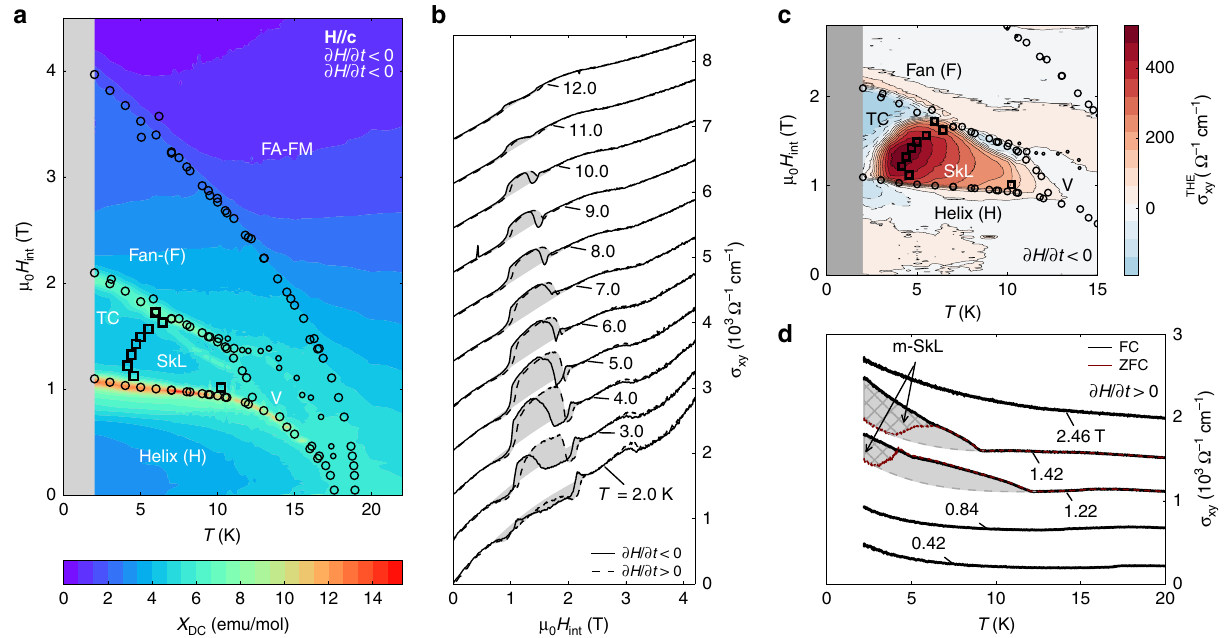
Fig. 2 Field-induced phase transitions in Gd 3 Ru 4 Al 12 and topological Hall effect in the SkL phase. a Contour plot of magnetic susceptibility χ DC = ∂ M / ∂ H in which we distinguish helical (H), fan-like (F), transverse conical (TC), and skyrmion lattice (SkL) states, as well as the as-yet unidenti fi ed phase (V). FA- FM labels the fi eld-aligned ferromagnetic state. Black open circles are phase boundaries obtained from χ DC for ∂ H / ∂ t , ∂ T / ∂ t < 0 (small symbols bound phase V. c.f. Supplementary Note 7). The transition between SkL and TC is marked by black open squares, corresponding to the onset of hysteresis between FC and zero- fi eld cooled (ZFC) cases in panel ( d ). b Isotherms of the Hall conductivity σ xy at various temperatures. Dashed and solid lines mark increasing and decreasing magnetic fi elds, respectively. A polynomial background was subtracted to identify the topological Hall conductivity σ xy THE (gray shaded area). Curves shifted by offsets of Δ σ xy = 680 Ω − 1 cm − 1 . c Large positive σ xy THE obtained from ( b ) is observed only in the SkL phase. Black open dots and squares indicate phase boundaries as in ( a ). d σ xy ( T ) at fi xed external magnetic fi eld, for FC (bold, black line) and ZFC (thin, red line) conditions. Outside the TC phase, ZFC and FC curves overlap. In the TC phase, the FC signal is larger due to the additional σ xy THE of metastable skyrmions (m-SkL, gray cross-hatched area). In the SkL state itself, we have estimated the background of σ xy with a polynomial (dark gray dashed line for μ 0 H int = 1.22 and 1.42 T) and marked the σ xy THE by gray coloring (no hatching). Curves shifted by offsets of Δ σ xy = 250 Ω − 1 cm − 1 for